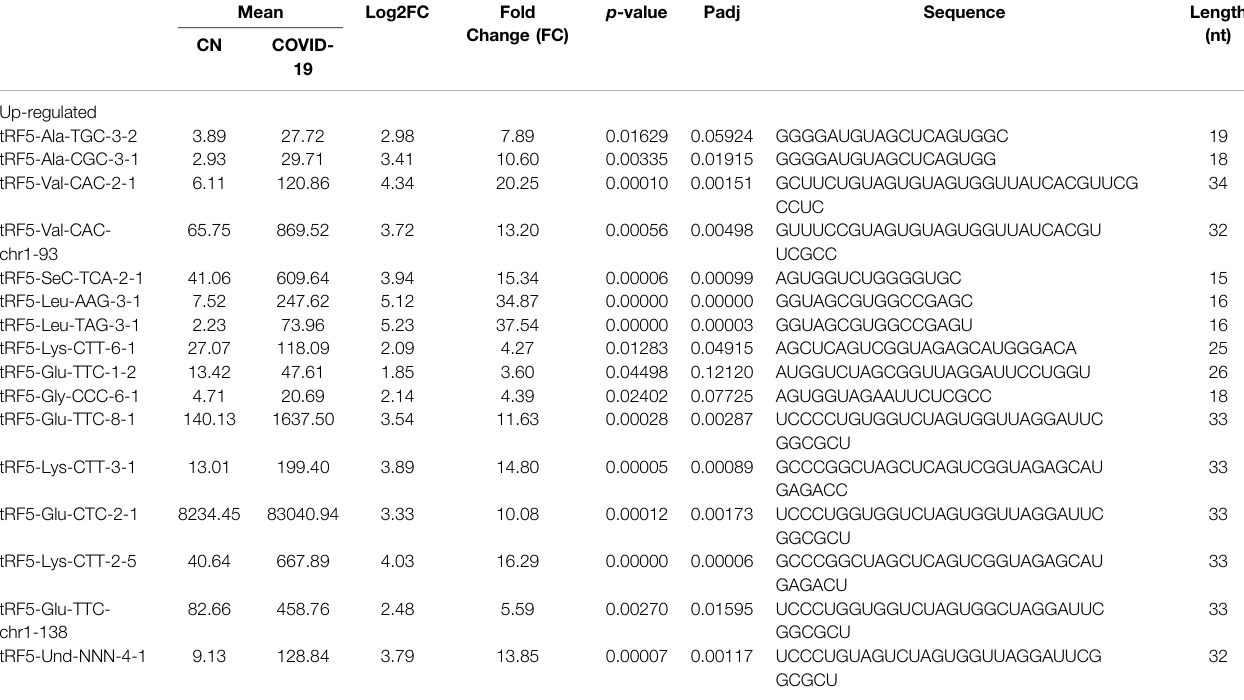
TABLE 5 | tRF5s with mean of normalized counts > 20 in Control (CN) or COVID-19